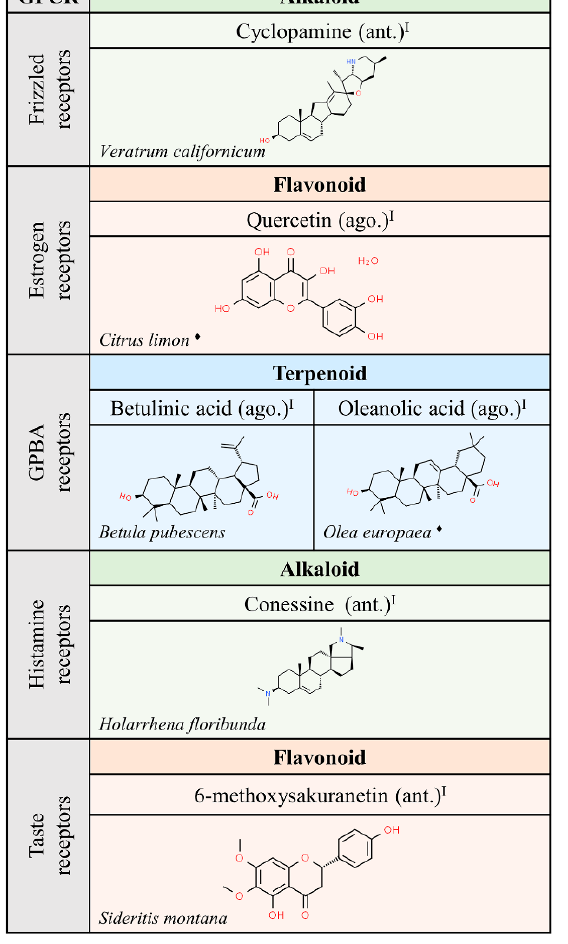
Figure 5. Natural ligands of GPCRs from plants (part. 3). Each chemical class is highlighted by different colors. The chemical structures were found on ChemSpider website. Legend: the plus symbol means that the compound is approved by the Food and Drug Administration. The rhomboid ( ♦ ) means that there are several examples of producing organisms. ago: agonist; ant: antagonist. Superscript: (I) [1].